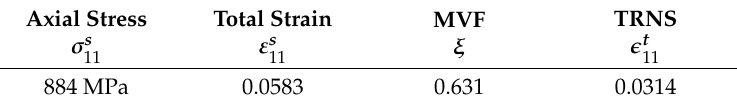
Table 6. SMA wires initial condition at cool-down